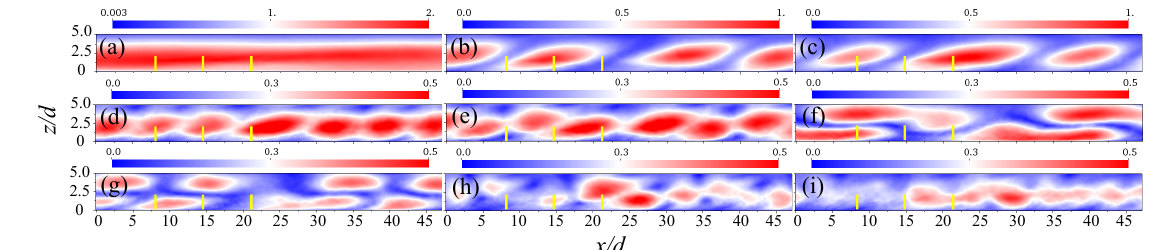
√ λ ϕ u k / U ∞ | . Thick yellow vertical lines–turbine locations. k |